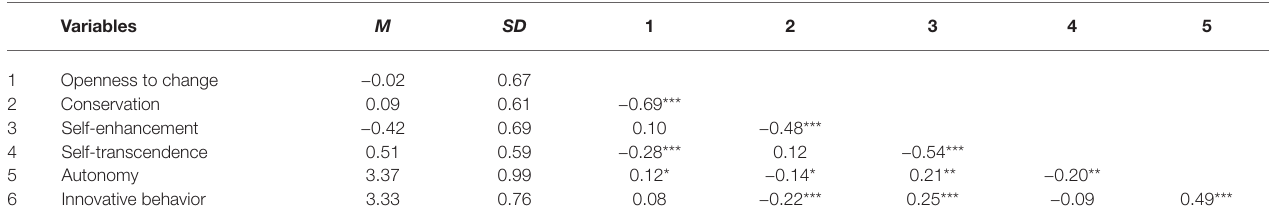
TABLE 1 | Means, standard deviations, and correlations between study variables ( N = 263). Variables